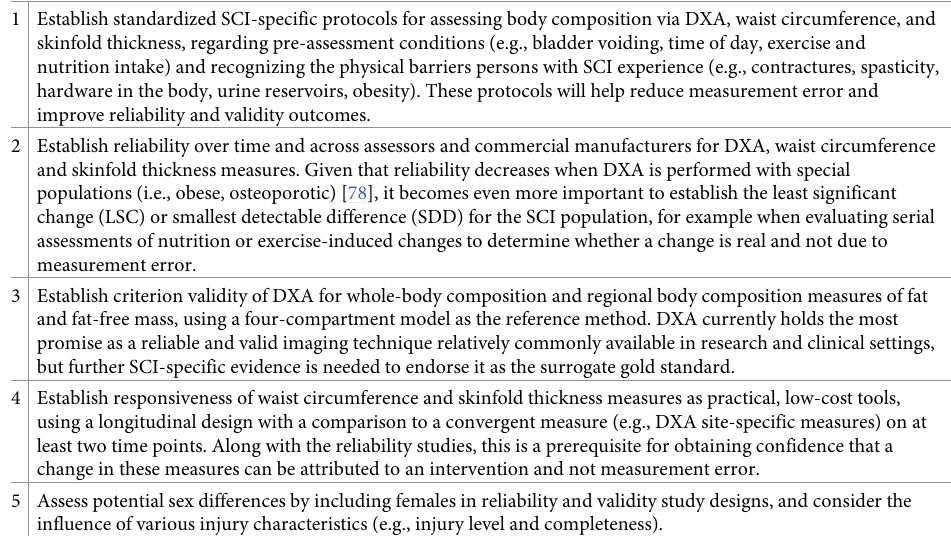
Table 3. Future priorities and considerations for research on measurement properties of body composition in the SCI